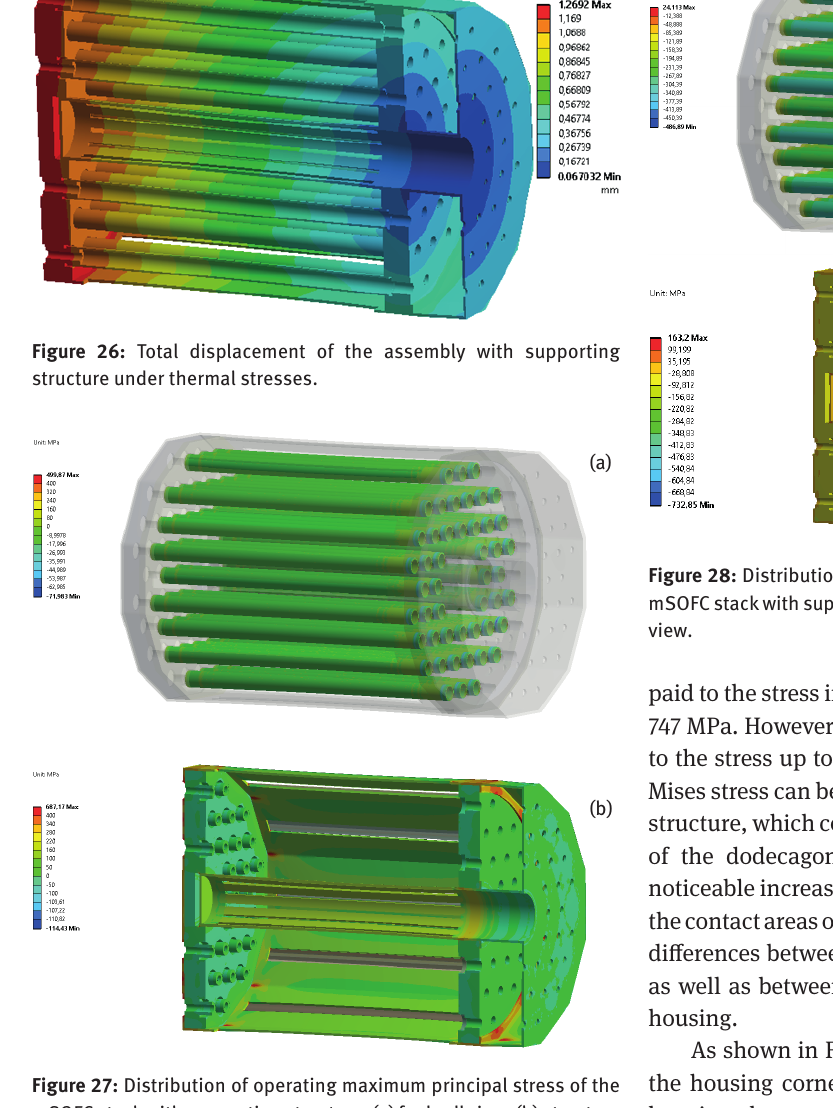
Figure 27: Distribution of operating maximum principal stress of the mSOFC stack with supporting structure: (a) fuel cell view, (b) structure view.